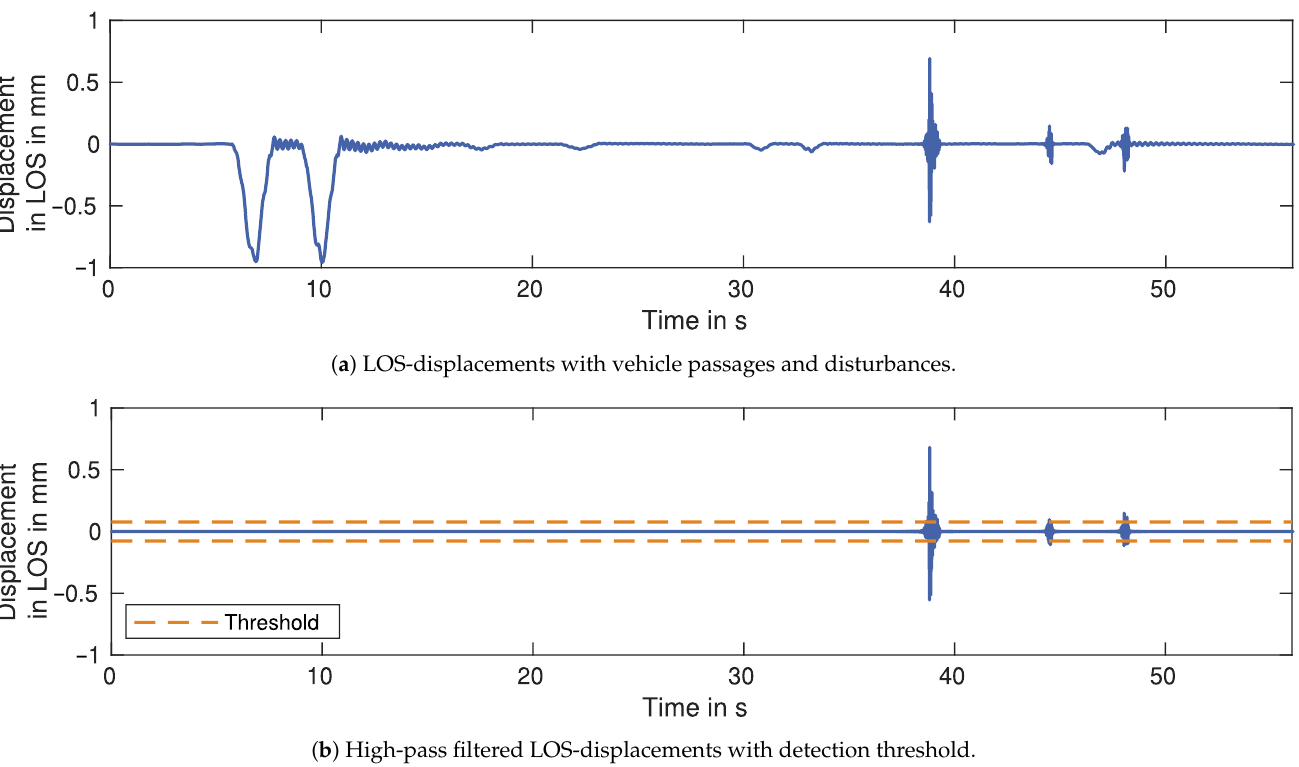
Figure 10. Section of LOS-displacements for Target 1 measured by GBR 1.